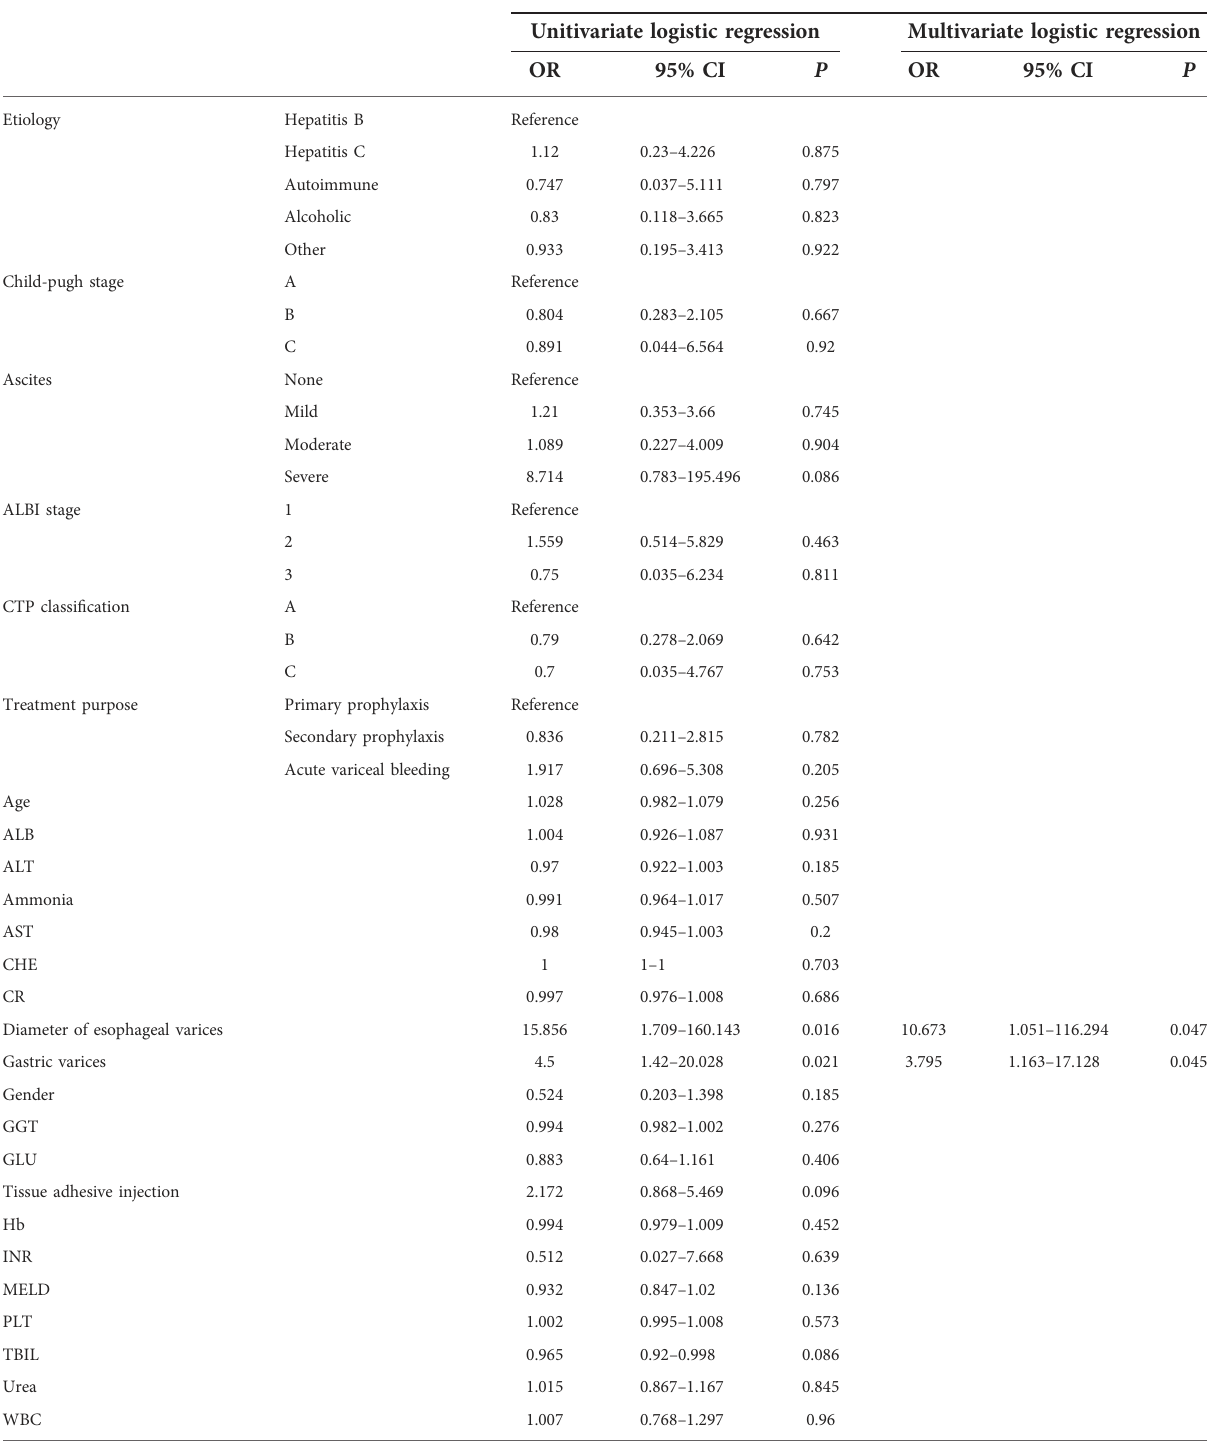
TABLE 4 Logistic regression analysis of intervention